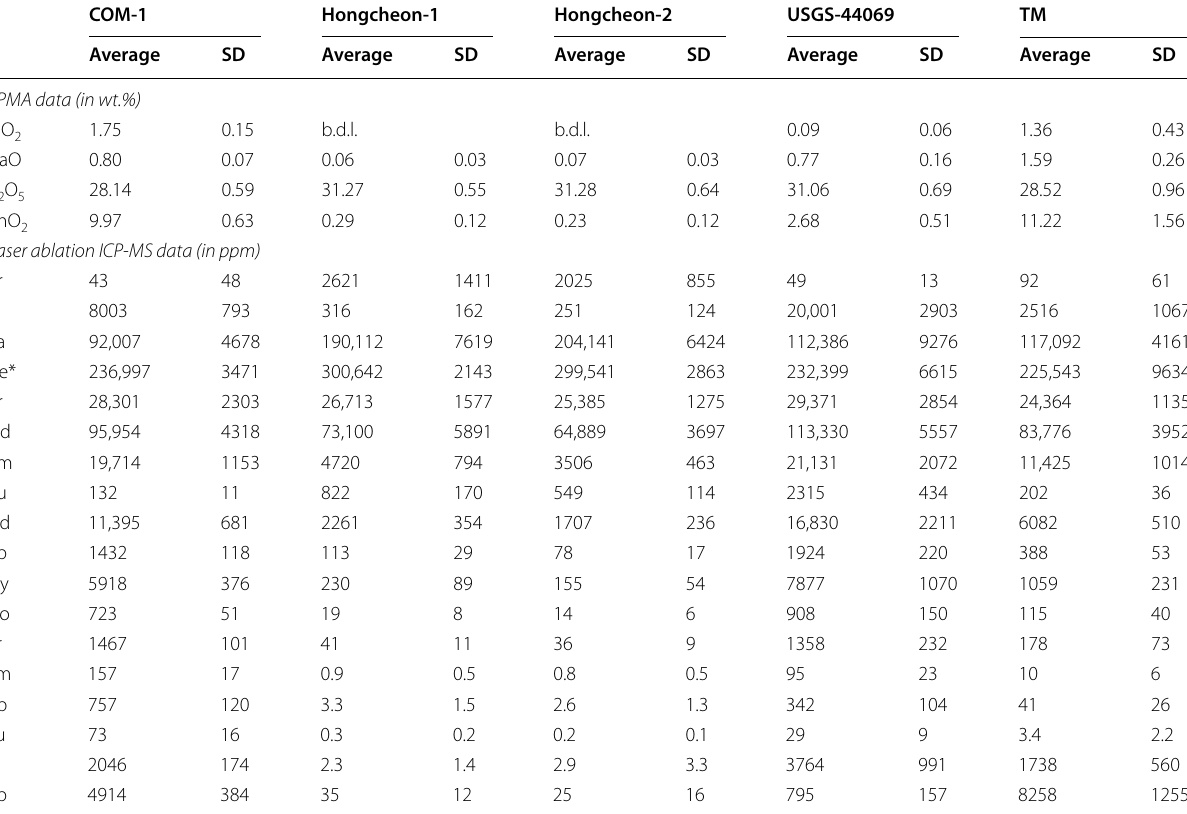
b.d.l.: below detection limit